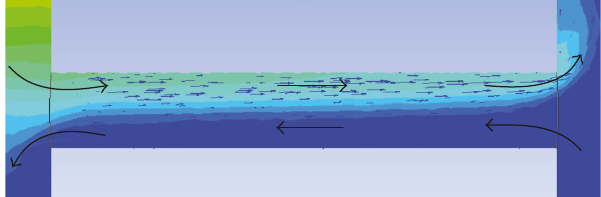
Figure 8: Velocity vector in IP in case 1 .